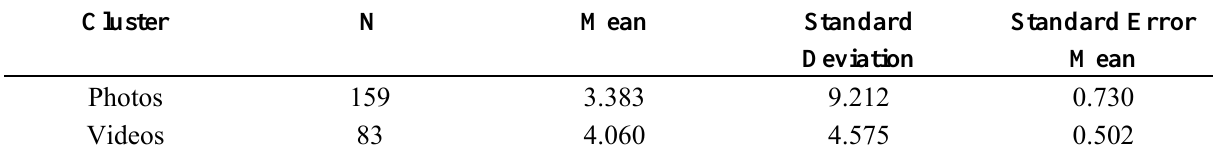
Table 5. Descriptive statistics of our sample.